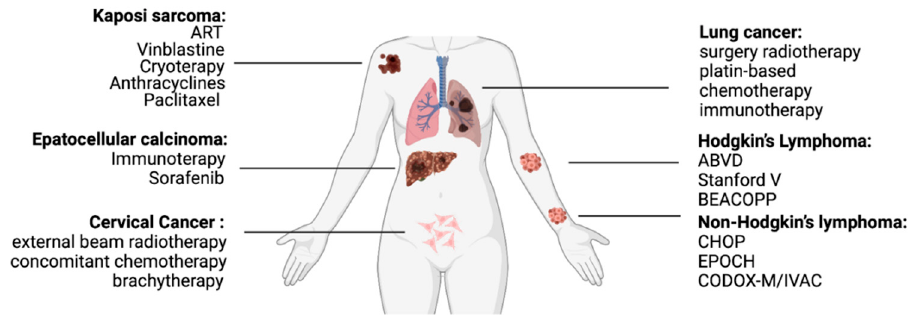
Figure 1. Most common type of tumor in HIV